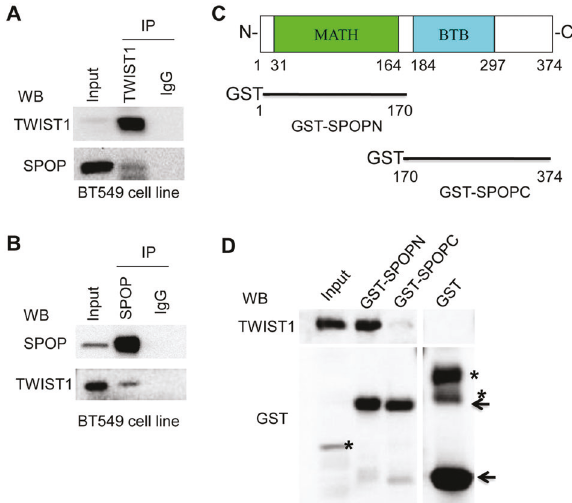
Fig. 5 SPOP interacts with TWIST1. Endogenous SPOP associated with endogenous TWIST1. TWIST1 precipitated ( A ) and co- precipitated ( B ) with SPOP. C Schematic illustration of GST-tagged C-terminal deletion mutant (GST-SPOPN) and N-terminal deletion mutant (GST-SPOPC) of SPOP. D N-terminal region of SPOP interacts with TWIST1